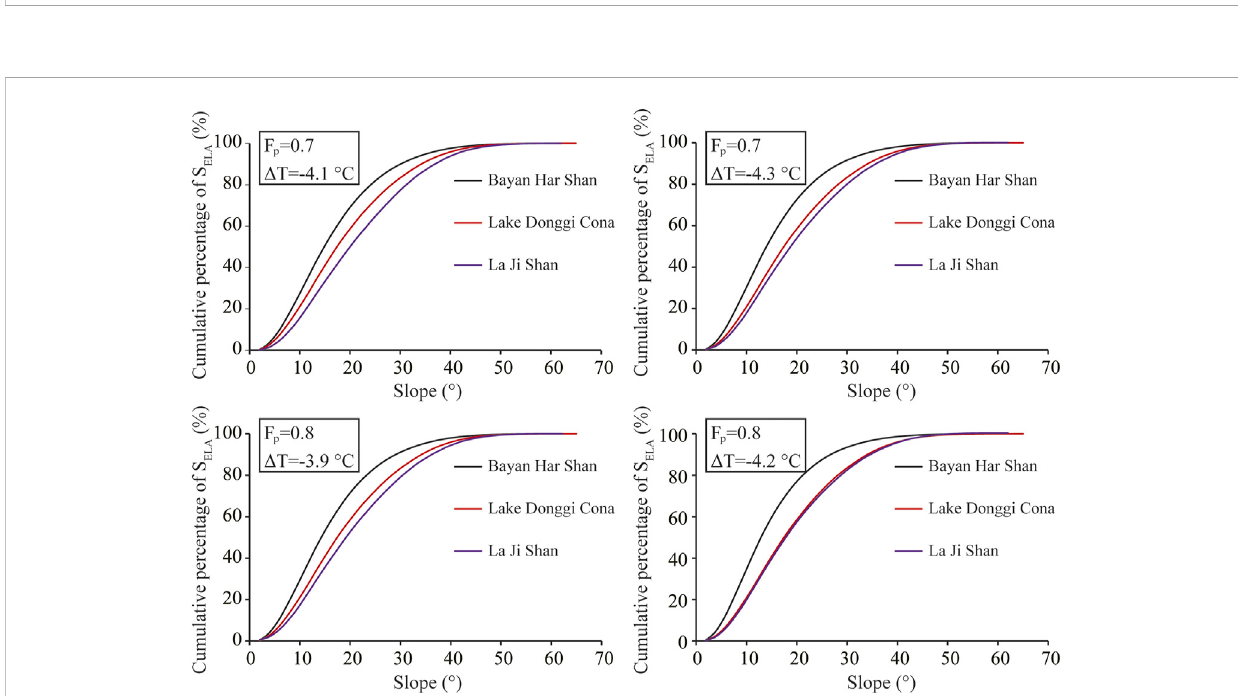
FIGURE 6 Cumulative percentages of the LGM S ELA in the study area for different LGM climatic conditions.